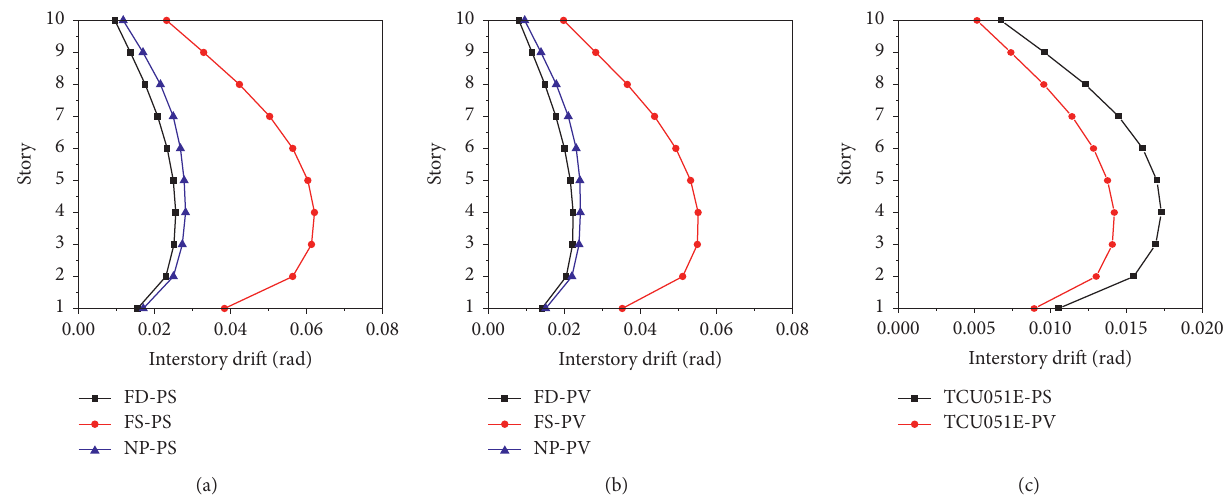
Figure 14: The average peak interstory drift of the structure under seismic excitations with velocity pulse: (a) the SSI system without viscous dampers; (b) the SSI system with viscous dampers; (c) the ground motion of TCU051E.